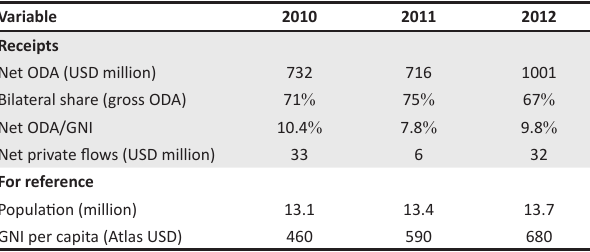
TABLE 2: The OECD flow of official development assistance to Zimbabwe from 2010 to